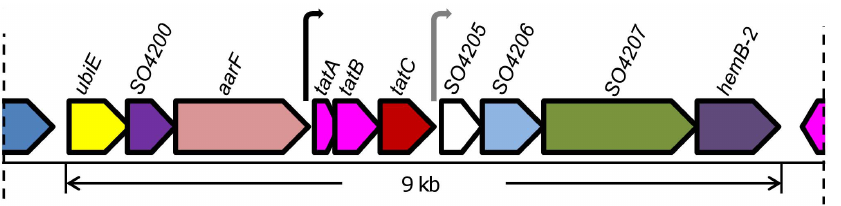
Figure 1. Genetic organization of tat genes from S.oneidensis . The marked region ( , 9 kb) is a fragment perfectly conserved in all 25 sequenced Shewanella strains (img.jgi.doe.gov). Arrows represent predicted promoters, of which the one in black is conserved in all Shewanella and the other in gray is identified in 23 sequenced strains. SO4206 is an analogue of E. coli tatD .